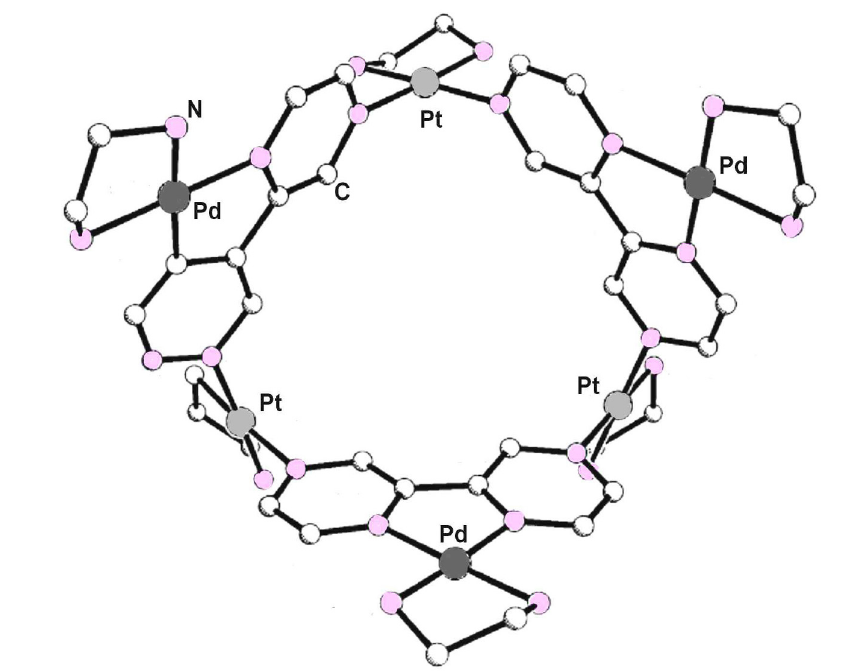
Figure 3. Structure of [{(en)Pt(µ-bpz)Pd(en)}